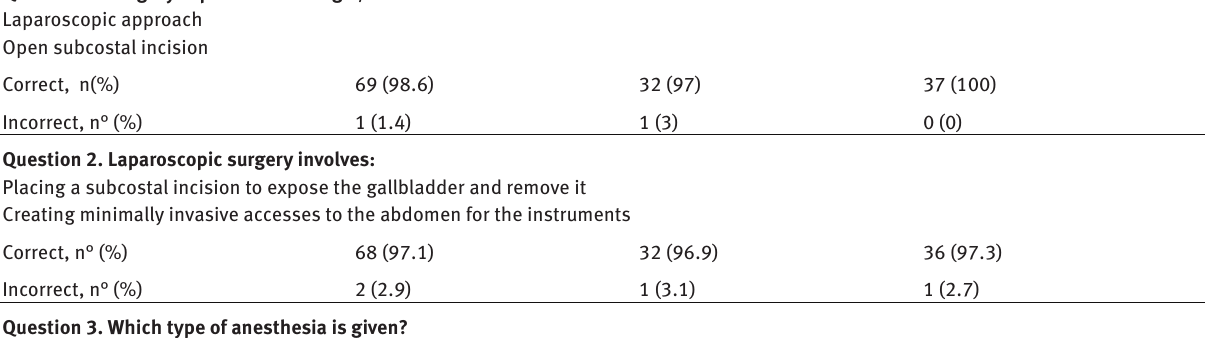
N° of patients (n=70) Study Group (n=33) Control Group